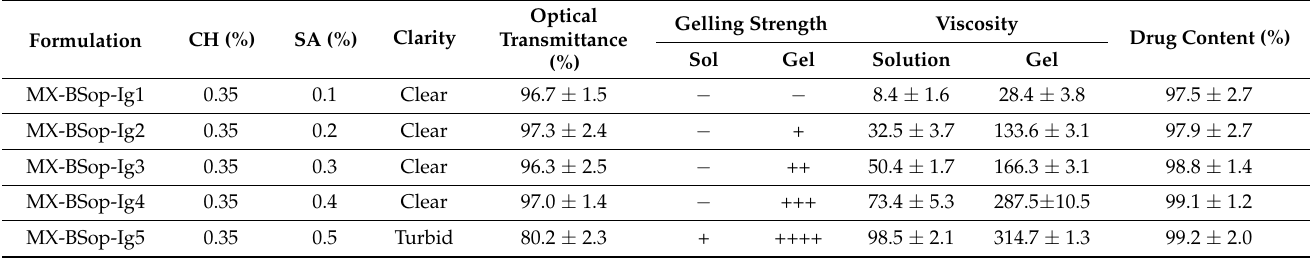
Table 2. Formulation and characterization parameters of